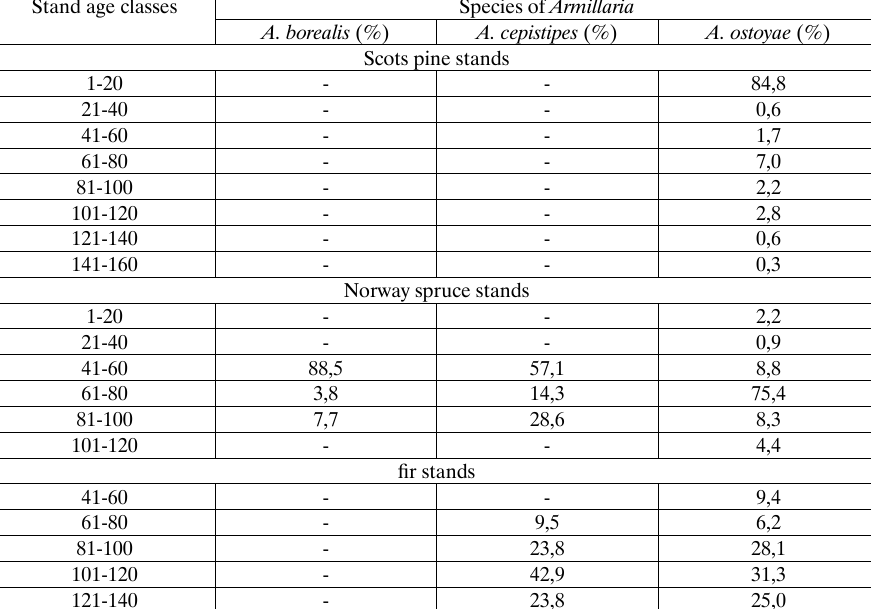
Percentage of particular Armillaria species in samples from coniferous stands of